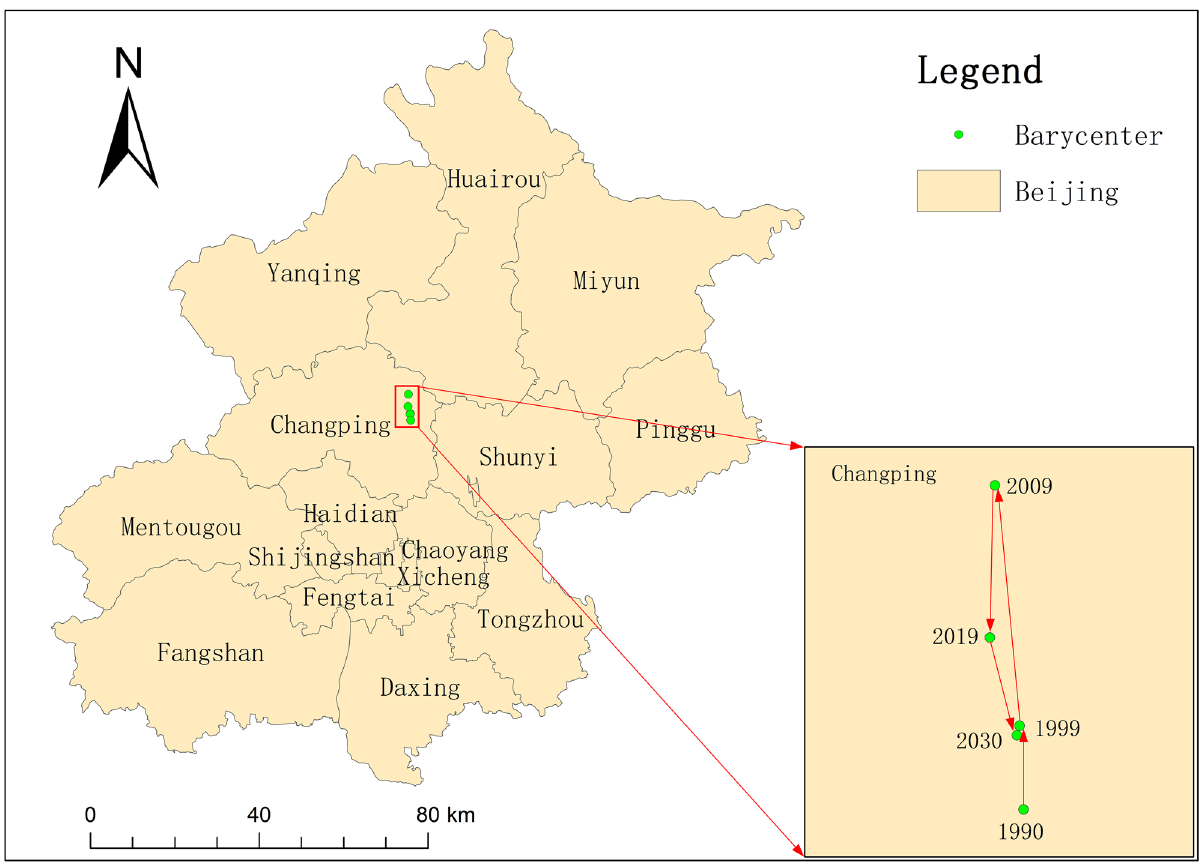
Figure 4. Barycenter migration of cores in Beijing from 1990 to 2030. The figure was drawn with ArcGIS sofware version 10.4. (https:// www. esri. com/ en- us/ arcgis/ produ cts/ arcgis- deskt op/ overv